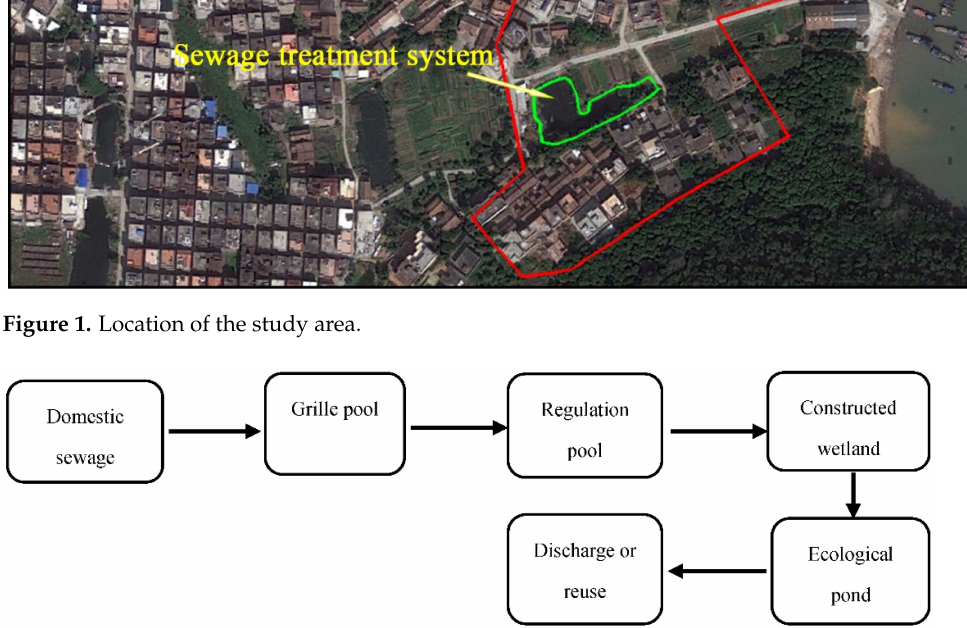
Figure 2. Sewage treatment process: Domestic sewage, grille pool, regulation pool, constructed wetland, ecological pond, and discharge or